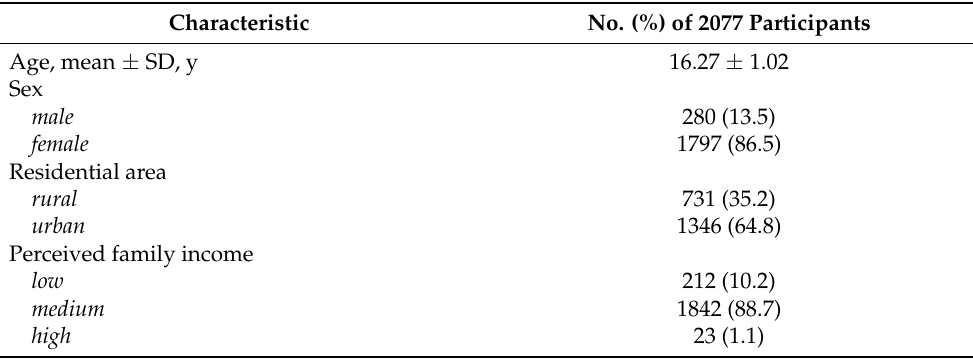
Table 1. Demographic characteristics of